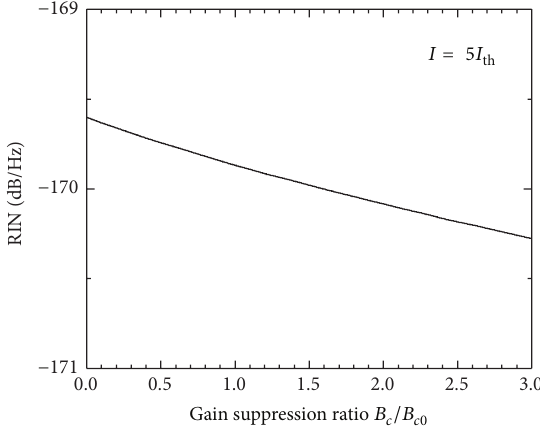
Figure 6: Influence of gain suppression factor on the LF-RIN level when 𝐼 = 5𝐼 th